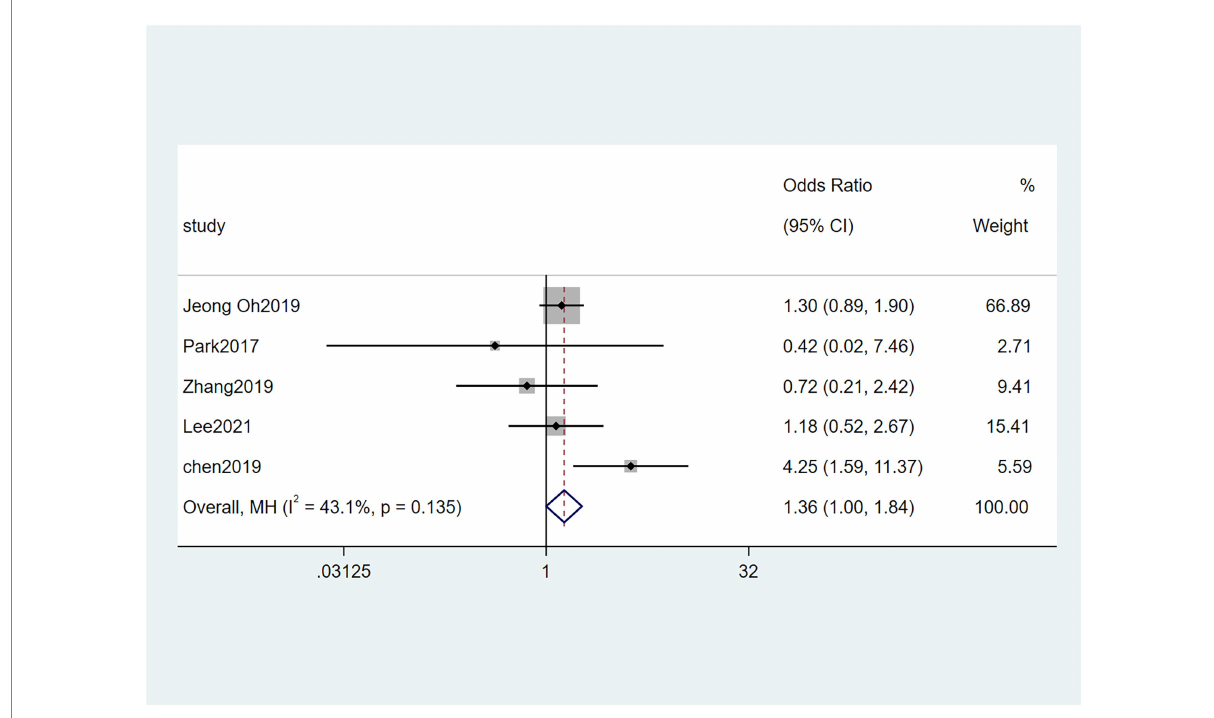
FIGURE 3 Forest plot of the relationship between Fusobacterium nucleatum and nerve invasion in